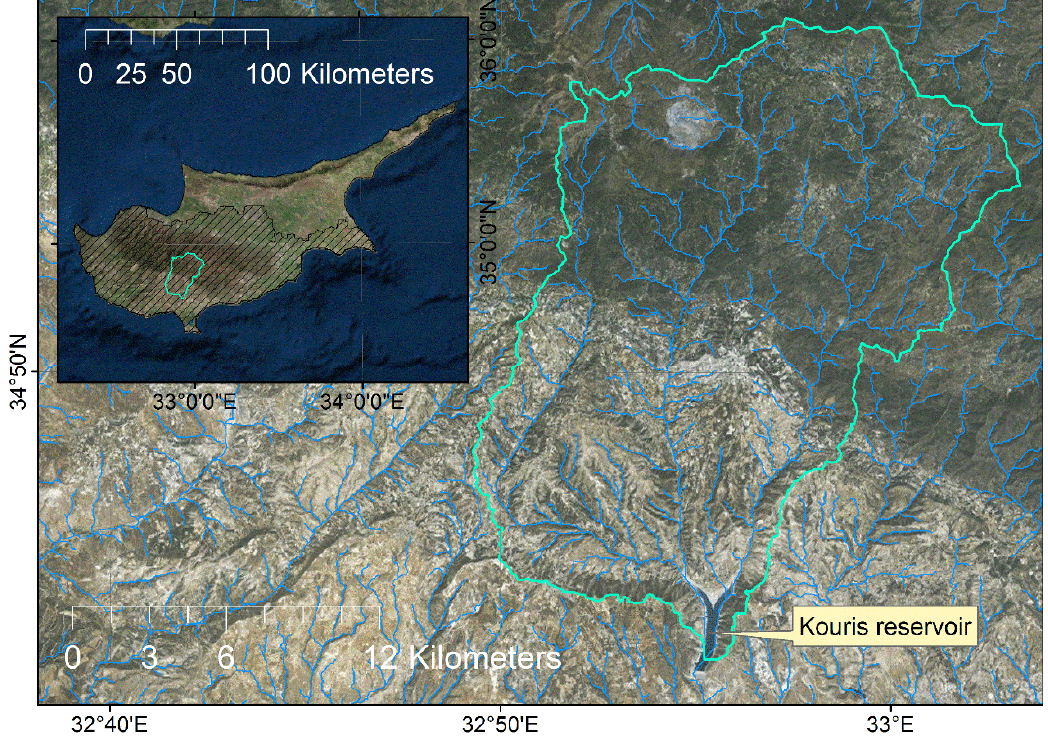
Figure 12. Located in the south part of Cyprus, Kouris reservoir was used for a risk assessment verification